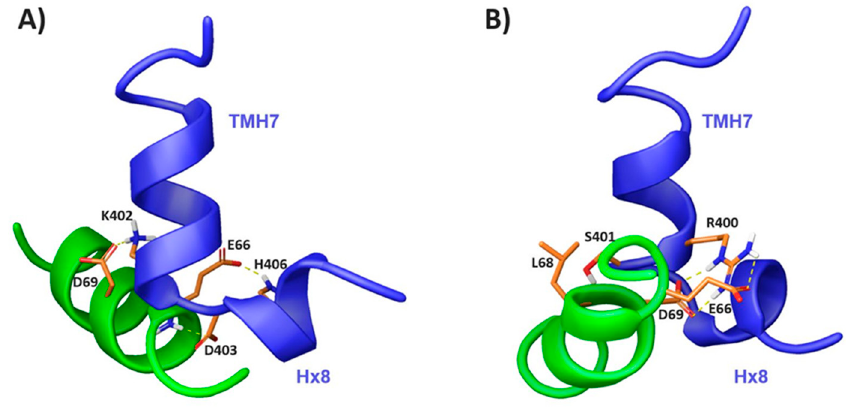
Figure 8. CB1 391-409 / β -arr1 63-76 complex models in TFE ( A ) and DPC ( B ). Main interacting residues are displayed in orange and yellow dashed lines represent hydrogen bonds.